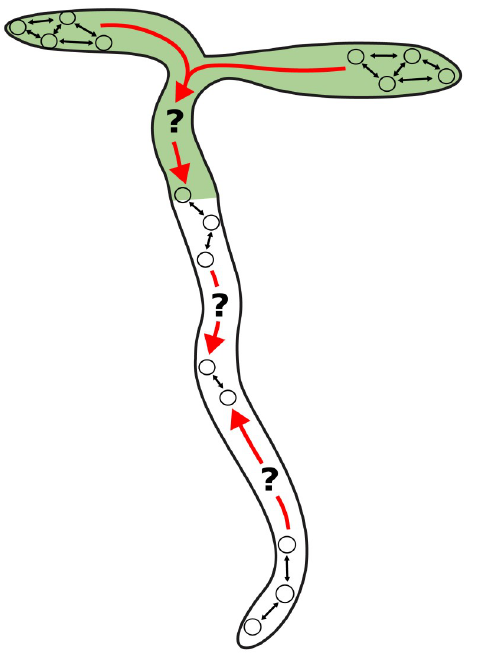
Fig 1. How do circadian clocks in different organs coordinate together? Individual clocks could communicate both within (black arrows) and between (red arrows) organs in order to coordinate plant timing.